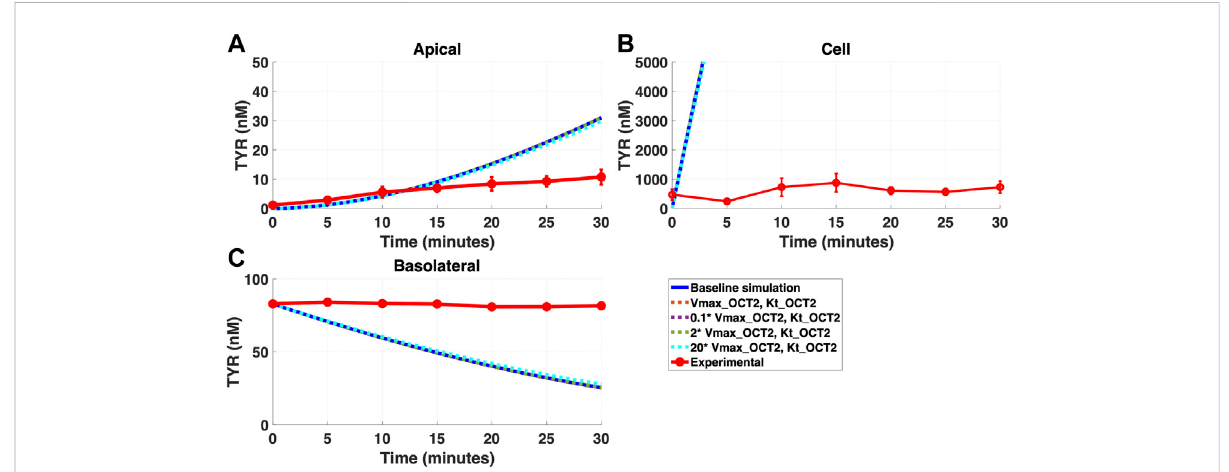
FIGURE 4 IntroductionofOCT2,ata range ofdensities,to the Caco-2 basolateralmembrane doesnot improvemodel accuracyfor basolateralTYR loading. The transport of 82.9 nM of TYR across Caco-2 cells was modeled following basolateral loading by solving Eqs 4 – 8, using the values mentioned in Supplementary Table S2, using MATLAB vR 2021a. Comparisons were made between the models (baseline = blue curve; modi fi ed = dotted curves) for the apical Panel 4 (A) , cellular Panel 4 (B) and basolateral compartments Panel 4 (C) , versus experimental observations; red curve (Sarkar and Berry, 2020).AdditionofanOCT2-liketransportertothebasolateralmembraneatvaryingdensitiesdidnotsigni fi cantlyaltermodelledTYRconcentration-time pro fi les. All of the curves have overlapped except experimental curve. Kinetic parameters used for this modelling were: V max_OCT2 = 0.1 nM/s, K